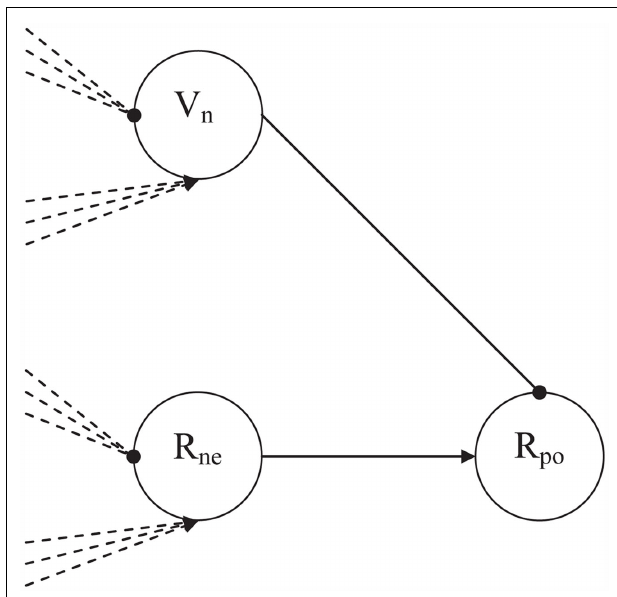
FIGURE 4 |The affective monitoring submodule with the R ne ,V ne , and R po nodes. Both R ne andV ne receive excitatory input from the other R-nodes and inhibitory input from the otherV-nodes.V ne activation decays quicker than R ne activation, so that R po will get activated particularly after fast reductions in level of competition.